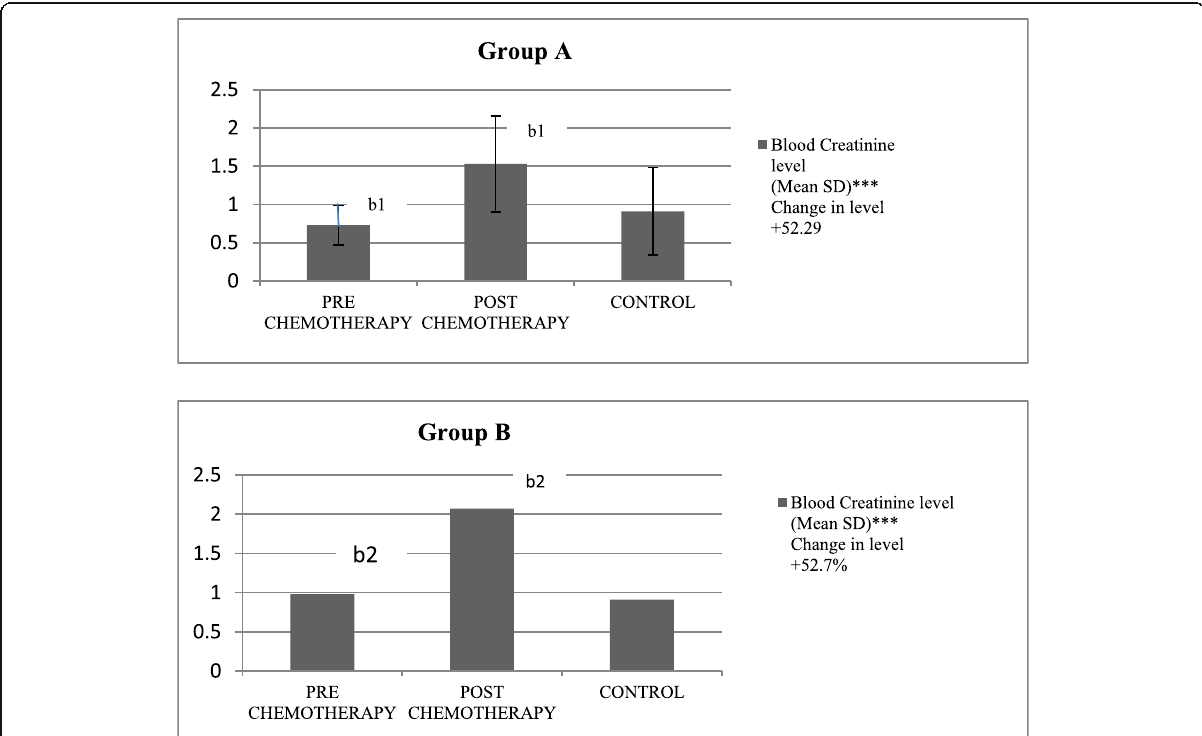
Fig. 2 Changes in serum creatinine level in both groups. *** p < .001 (extremely significant). On comparing the pre and post chemotherapy patients in group A by Tukey-Kramer multiple comparisons test, the significance level is indicated by b1, b2: p < .001 (extremely significant). Change in terms of increase in levels are indicated by plus